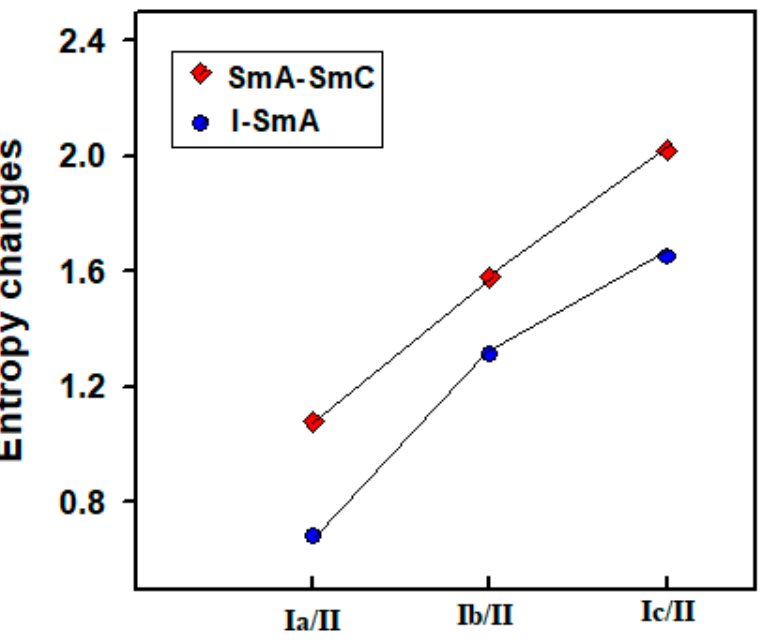
Figure 6. Entropy changes upon cooling of mesomorphic transitions of designed complexes Ix/II .